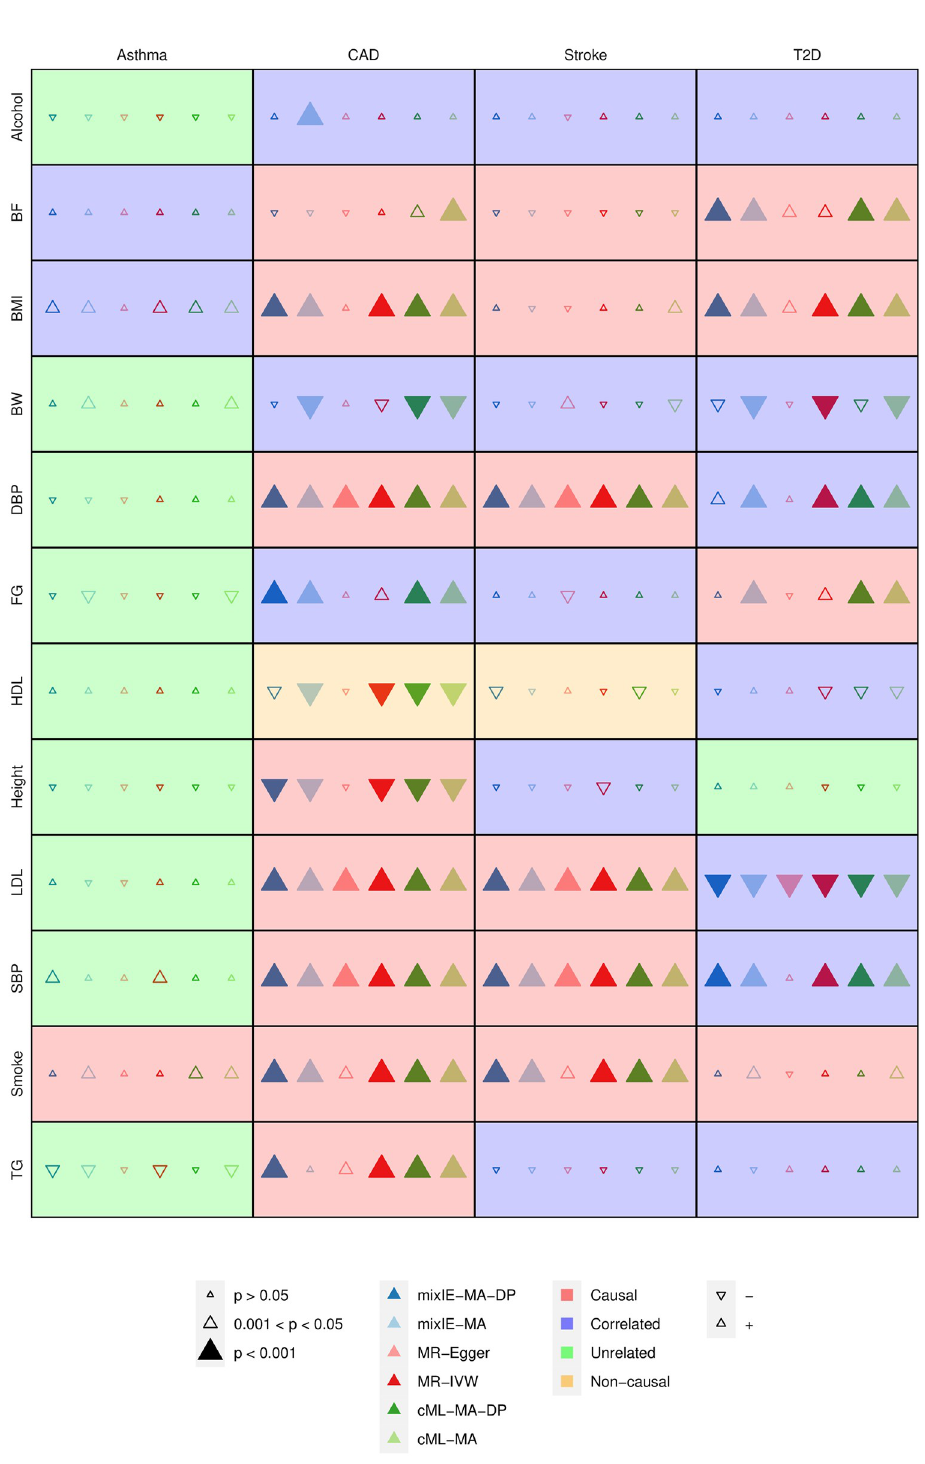
Fig 10. Results of various methods to detect causal relationships among 48 risk factor-disease pairs.